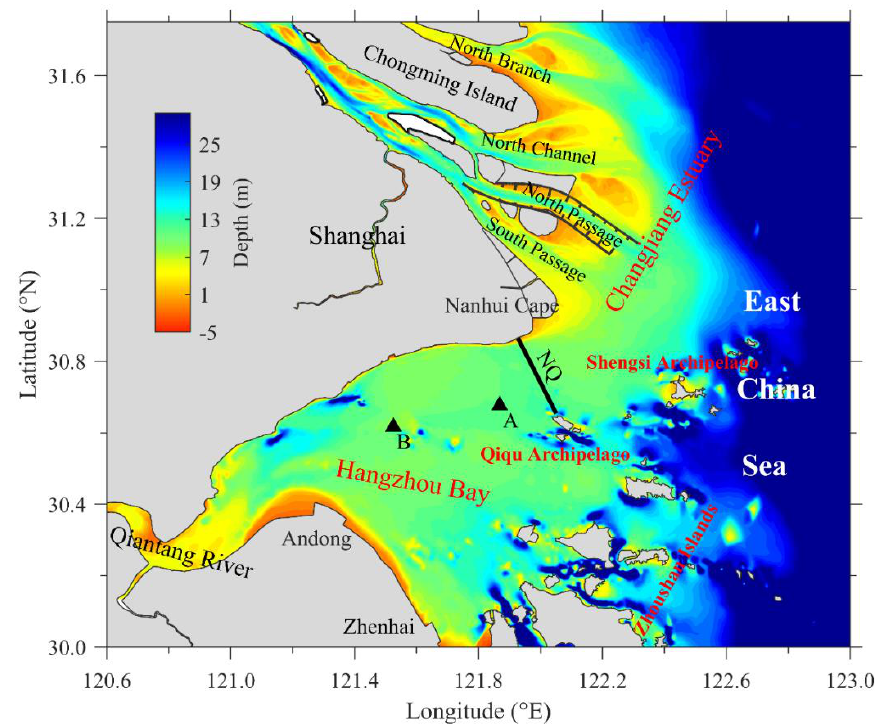
Figure 1. Map of Hangzhou Bay and Changjiang Estuary. Black triangle: the anchored ship stations; thick black line: section from Nanhui Cape to Qiqu Archipelago.